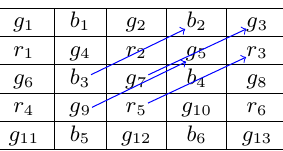
Figure 3. Example of gradient calculation for g 7 according to Equation 4